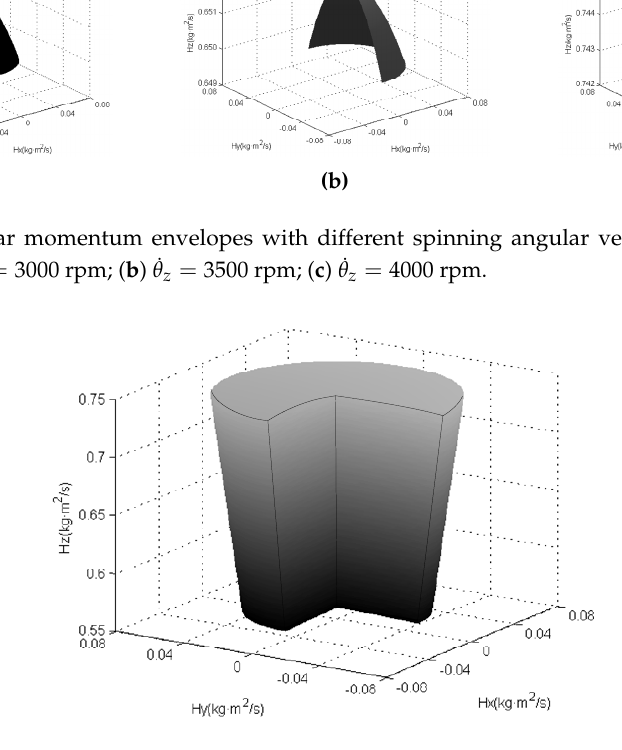
Figure 4. Cut-away view of the angular momentum